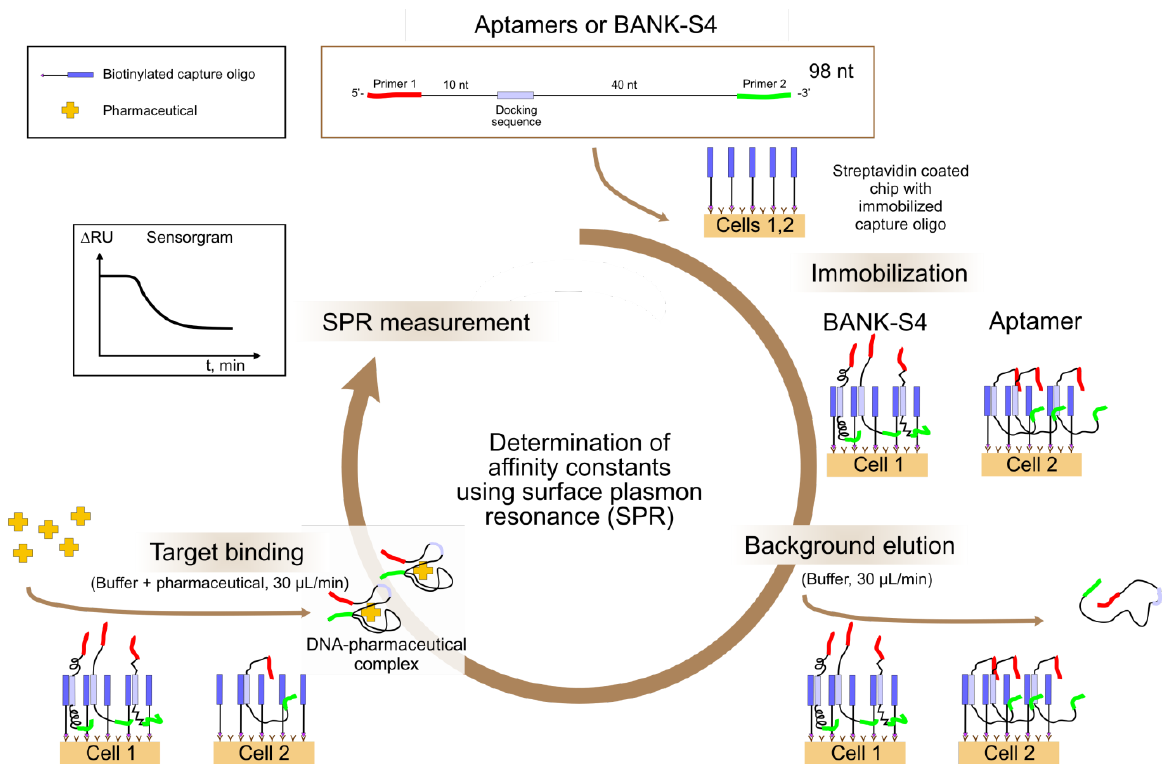
Figure 4. Methodology of the affinity tests performed by SPR detection. Aptamers: Depicted exemplary is a full length aptamer with 98 nucleobases displaying both primer binding sites. In case of deletions of single nucleobases during selection or in case of the use of truncated versions of the aptamers, the sequences are